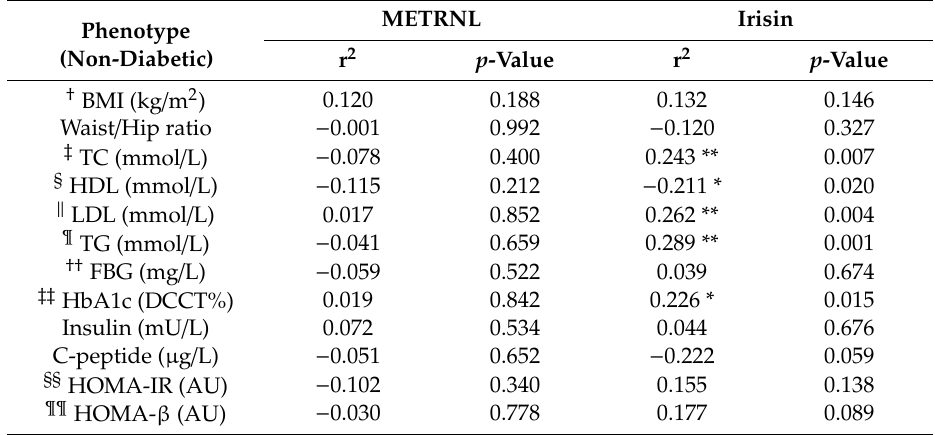
Table 6. Correlation between circulating METRNL and irisin proteins and physical, clinical, and biochemical parameters in non-diabetic population adjusted for age and gender.